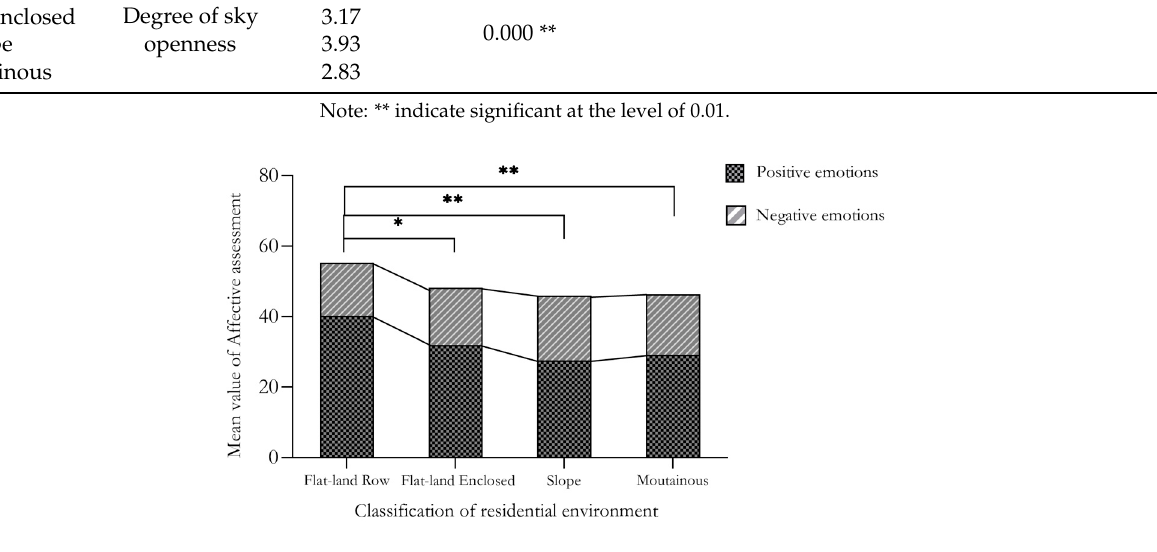
Figure 1. Emotional assessment of different types of residential environments. Note: *, ** indicate significant at the level of 0.05 and 0.01 respectively.